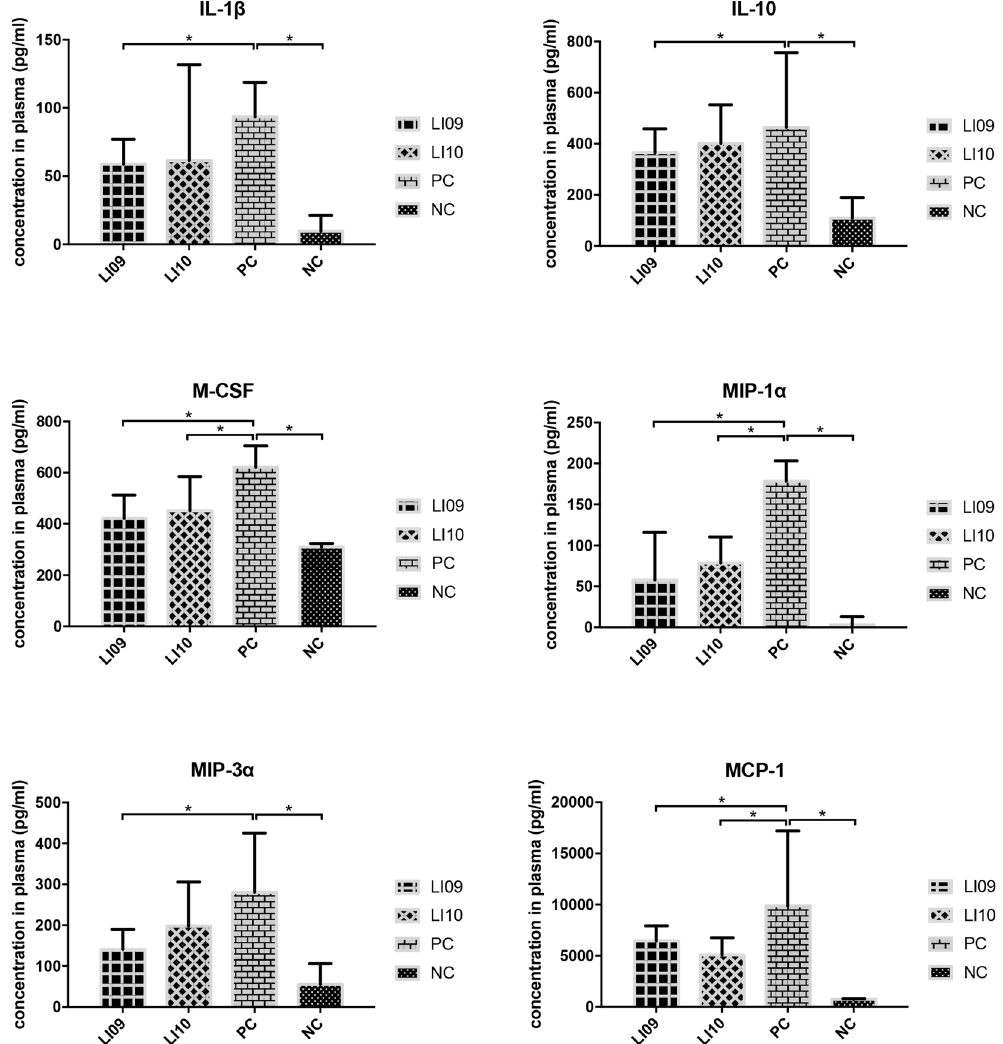
Figure 2. Effects of pretreatment with B. pseudocatenulatum LI09 or B. catenulatum LI10 on hypercytokinemia during D-GalN-induced acute liver injury. Values are expressed as the median with interquartile range. * p < 0.05 compared with the PC group.